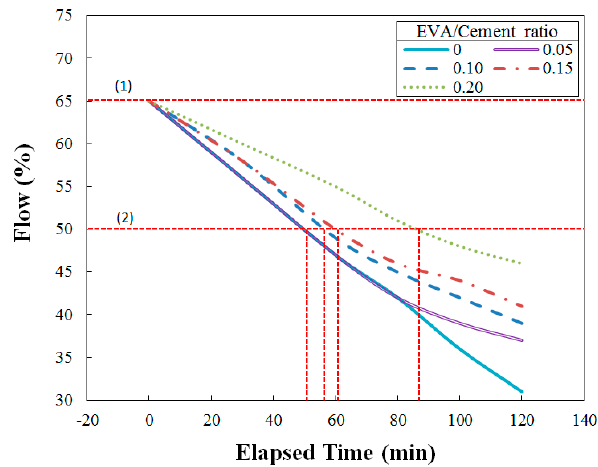
Figure 3. Elapsed time versus flow [15].